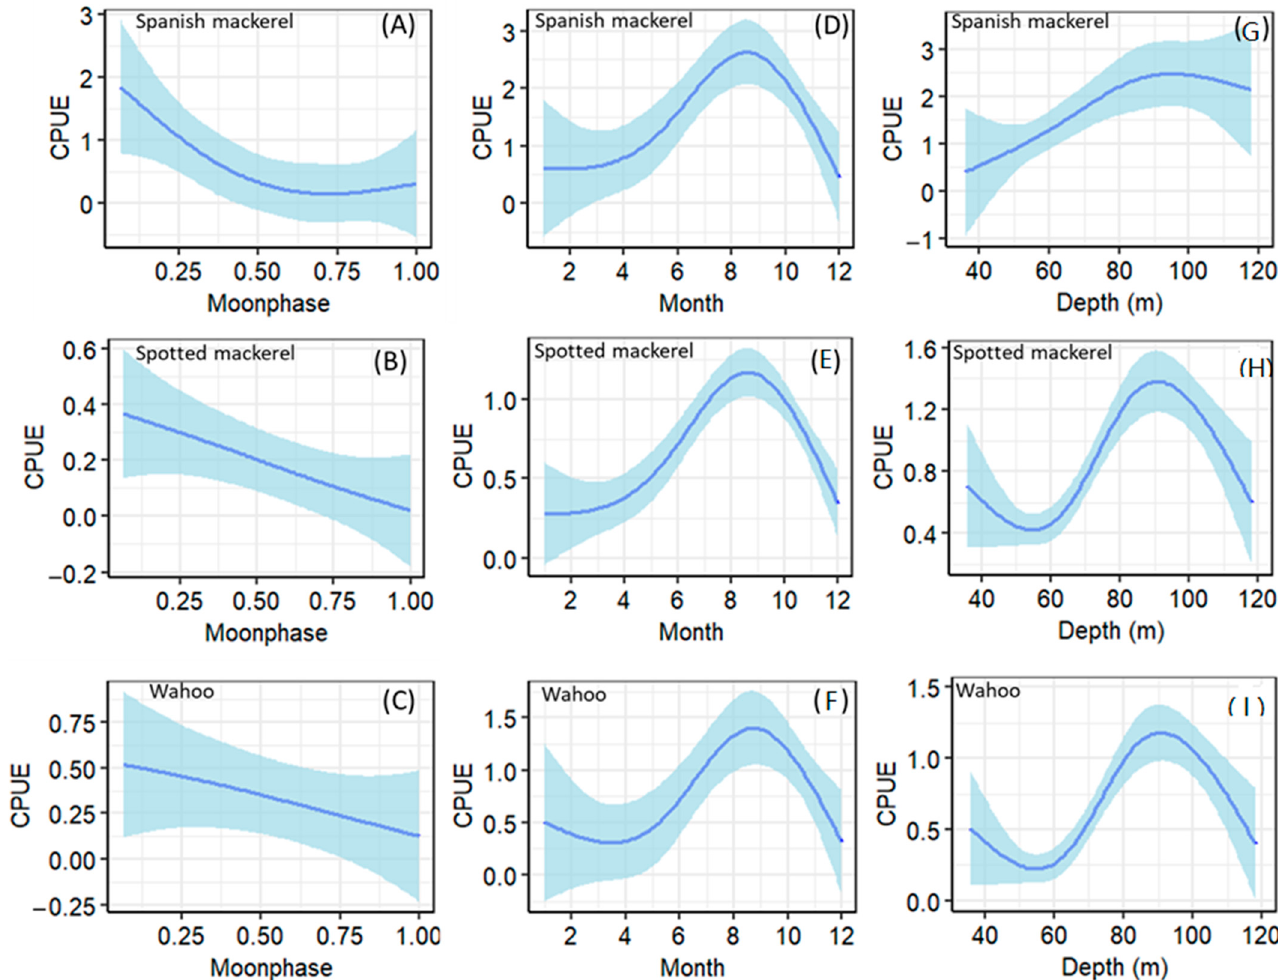
Figure 5. Predicted CPUE (number of fish caught per h for webbing) obtained from the GAMs for catch of narrow-barred Spanish mackerel, spotted mackerel, and wahoo in relation to moon phase ( A – C ), fishing month ( D – F ), and depth ( G – I ). Blue curves indicate mean values obtained from the models. Shaded areas represent 95% confidence intervals. Negative confidence intervals indicate that they are not statistically signi fi cant.